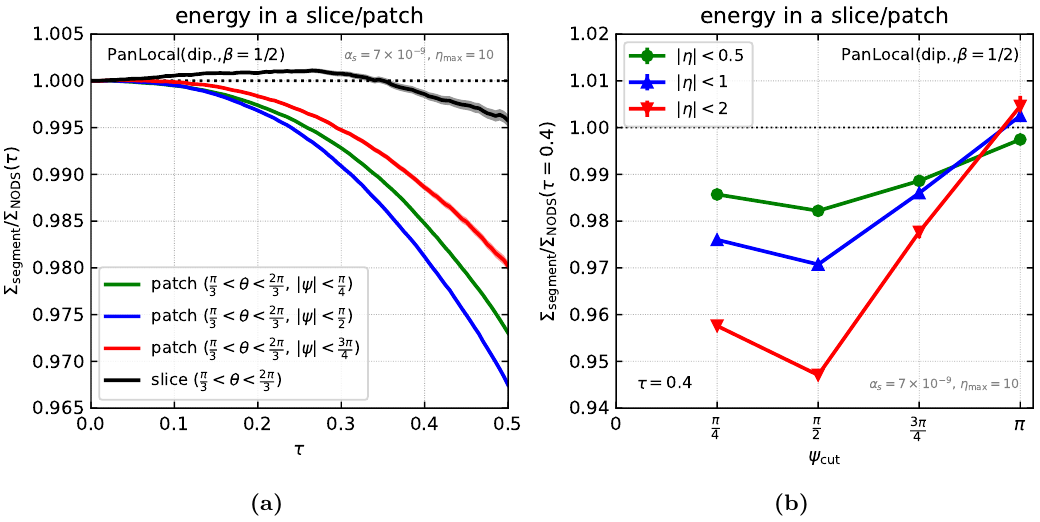
Figure 17. (a) Ratio between the segment and NODS methods for the energy deposited in a square patch of finite rapidity and azimuthal extent, as a function of τ defined in eq. (7.10). The bands correspond to the statistical uncertainty. (b) Same shown as a function of the azimuthal extent of the patch for different rapidity widths and for τ = 0 . 4